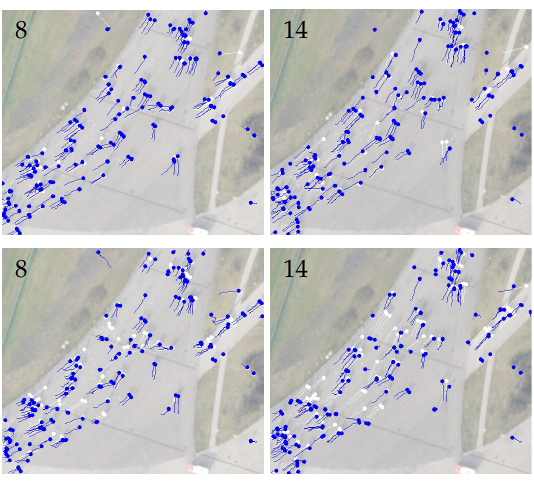
Figure 13. Tracking results by AerialMPTNet ( top row ) and SMSOT-CNN ( bottom row ) on the frames 8 and 14 of the “AA_Walking_ 02” sequence of the KIT AIS pedestrian dataset. The predictions and ground truth are depicted in blue and white, respectively.